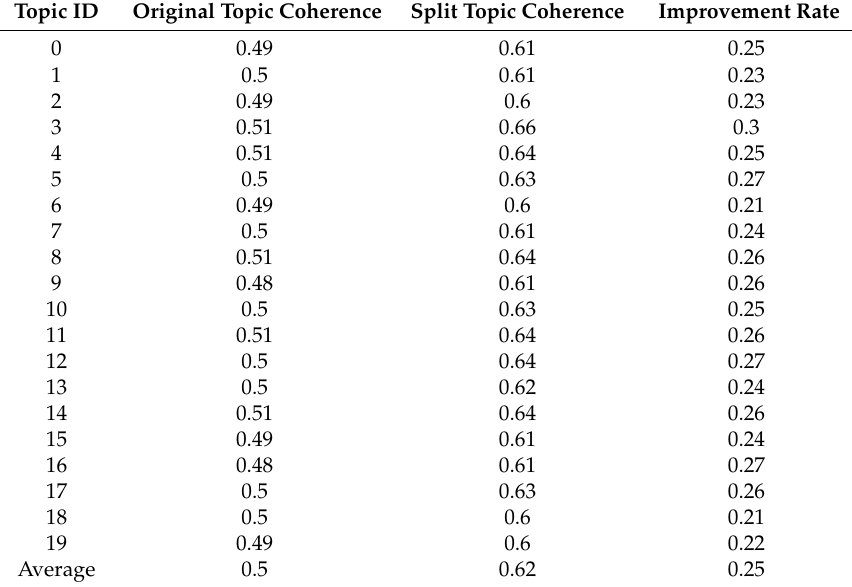
Table 8. Results of original and split